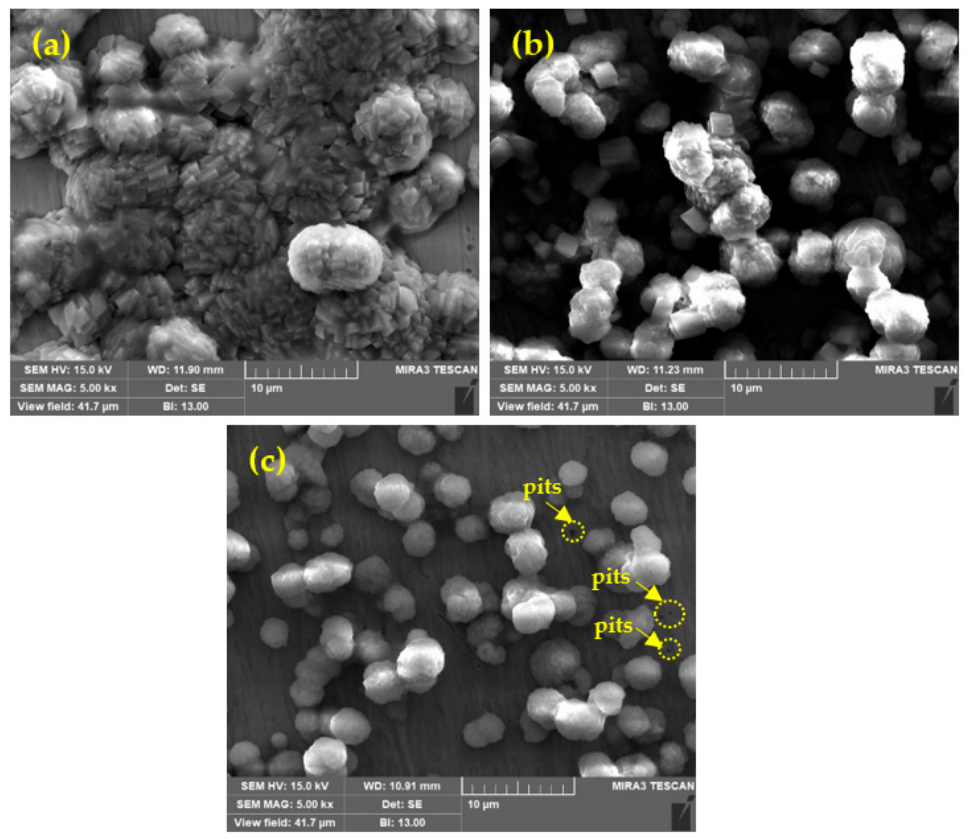
Figure 8. SEM after 168 h of immersion in ( a ) SP-0, ( b ) SP-1, and ( c ) SP-2 solutions. Table 5. EDS analysis of passive